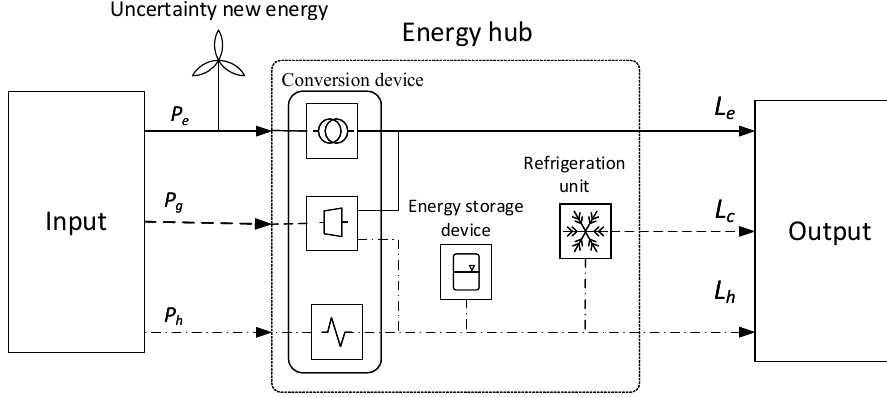
Figure 1. Simplified structural diagram of an energy hub.